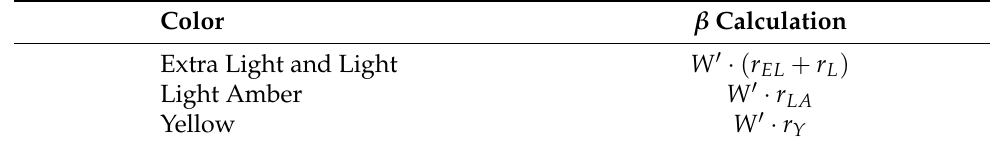
Figure A1. Quarter products. Table A1. Types of quarters.